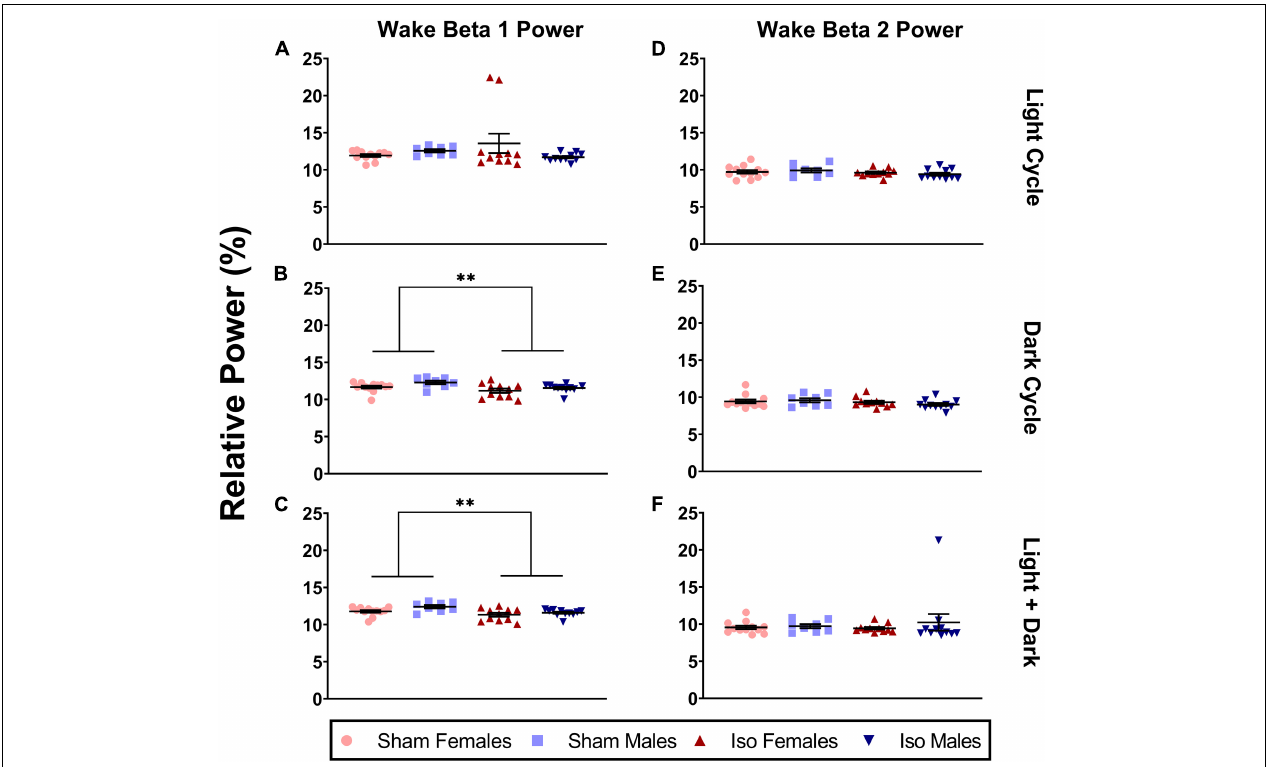
FIGURE 6 | Neonatal isoflurane exposure resulted in a small but significant decrease in power spectra in the beta 1 frequency band, but not in beta 2 during the wake period. (A) This was not statistically significant in the light cycle ( P = 0.076), (B) but instead was seen in the dark cycle when animals are most active (* P = 0.001), and (C) in both cycles combined (** P = 0.003). For beta 2 oscillations, changes were not statistically significant during (D) the light cycle ( P = 0.173), (E) the dark cycle ( P = 0.215), and (F) in both cycles combined ( P =